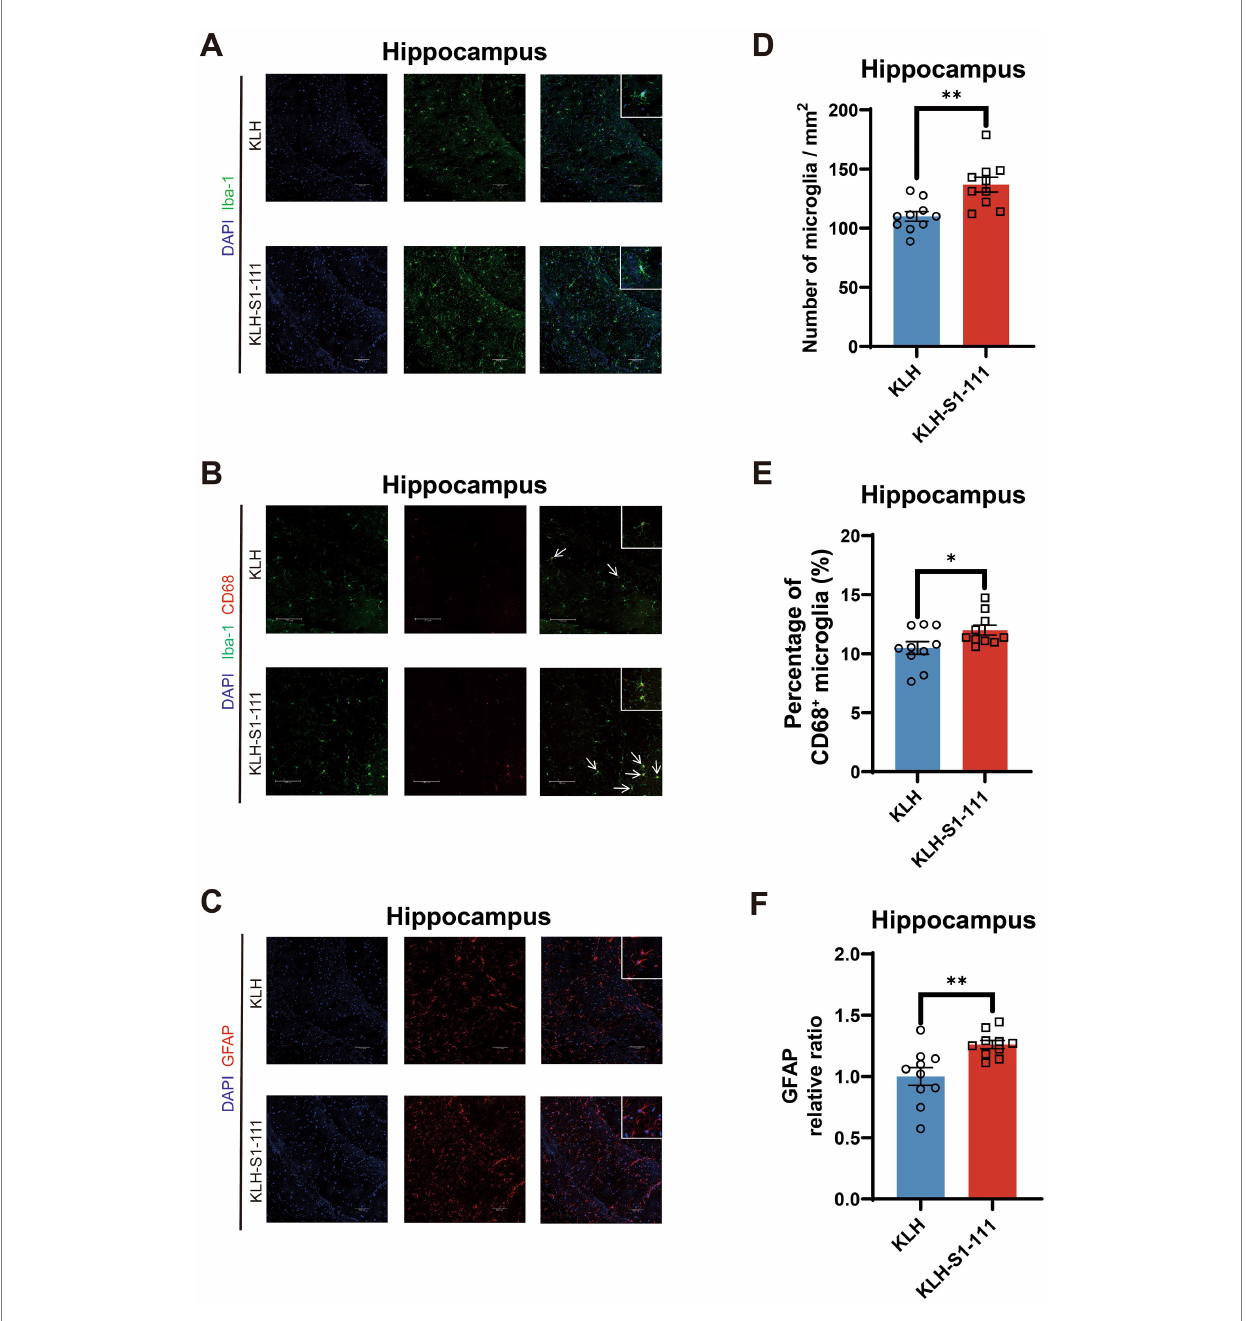
FIGURE 4 Evaluating of the effect of endogenous anti-S1-111 antibodies on hippocampal glial cells. Representative images depicting immunofluorescence staining in the hippocampus (A) for Iba1 + microglia, (B) for Iba1 + and CD68 + microglia, and (C) for GFAP + astrocytes. Magnification 20× objective field with 100 μ m scale bars for A and B, and magnification 40× objective field with 100 μ m scale bars for C; white boxes indicate the enlarged insert of a representative cell with 10 μ m scale bars. (D) Quantification of Iba1+ microglia cells ( p = 0.002). (E) Quantification of Iba-1 + and CD68 + double-positive area in Iba1 + area ( p = 0.0419). (F) Quantification of GFAP + astrocytes ( p = 0.0041). (D-F) . N = 10/group, unpaired Student’s t test, data are shown as the mean ±